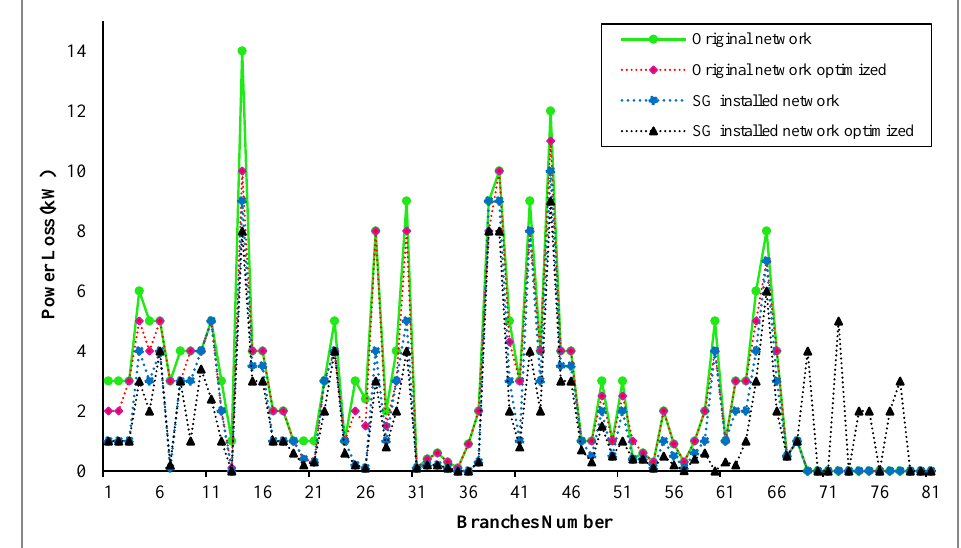
Figure 13. Power loss dispersion of IEEE model distribution network